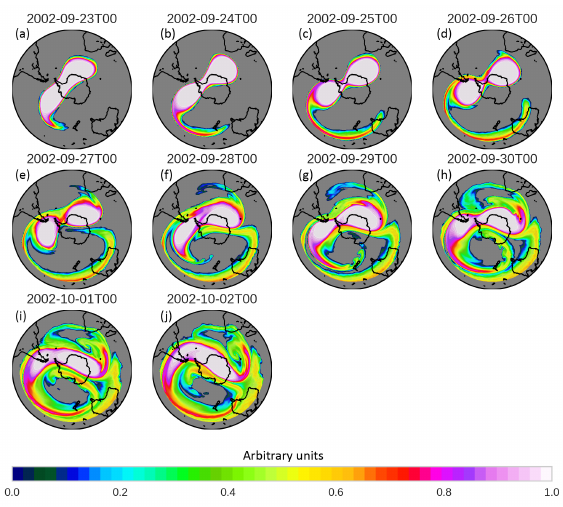
Figure 6. Daily snapshots at 00:00UTC at 30hPa of the passive vortex tracer in arbitrary units (upper left to bottom right). The pas- sive tracer was set to 1 within the vortex boundary at the beginning of the integration. Table 2. Overview of the boundary conditions used in the AMIP- like